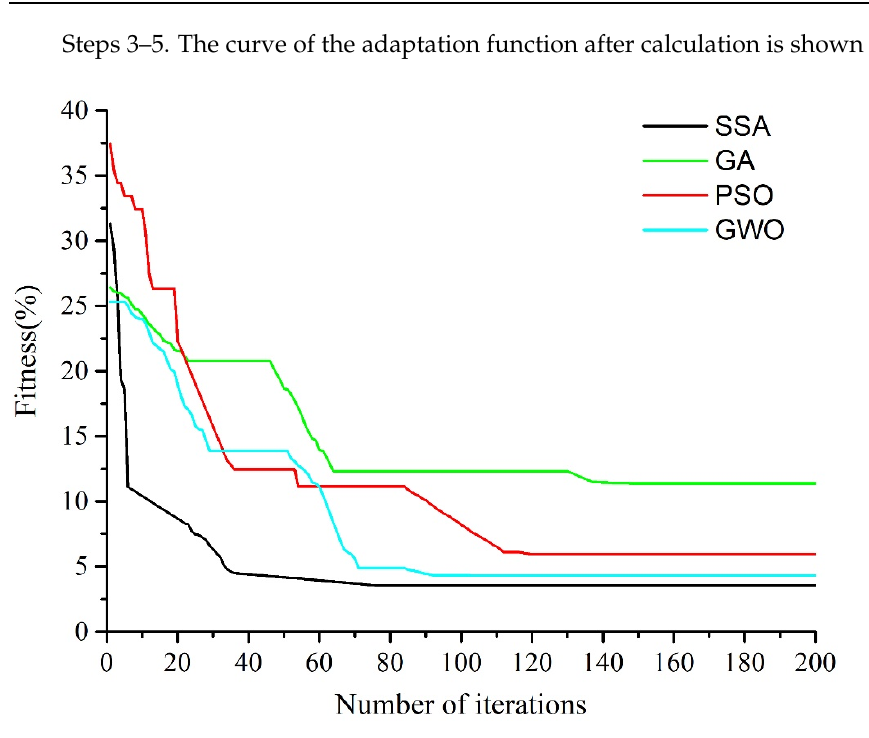
Figure 2. Curve of the adaptation function.